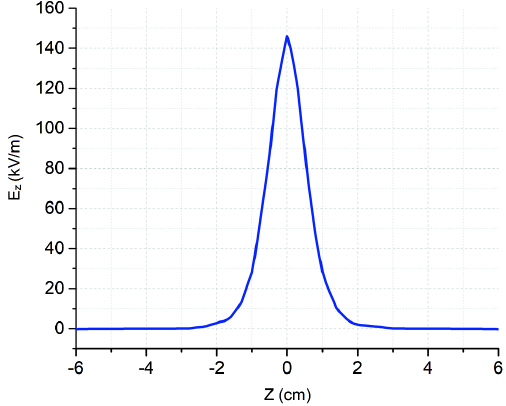
FIG. 31. MHB longitudinal electric field along the beam axis.